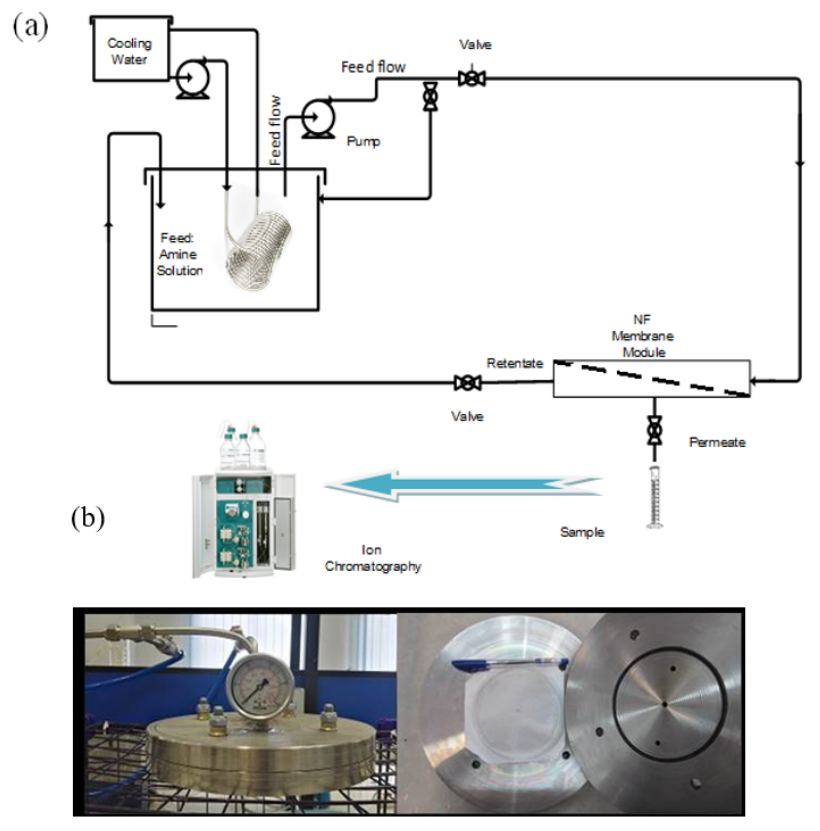
Figure 7. Scheme of experimental set-up ( a ) and images of nanofiltration (NF) membrane holder ( b ).